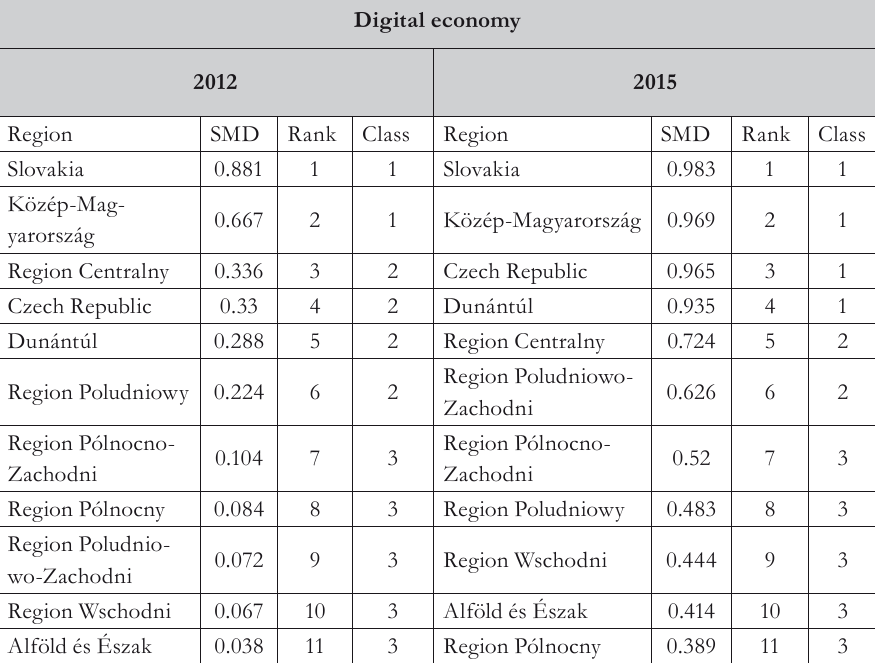
Tab. 2 – Ranking and grouping of regions for Visegrad countries for the years 2011 and 2015. Source: own